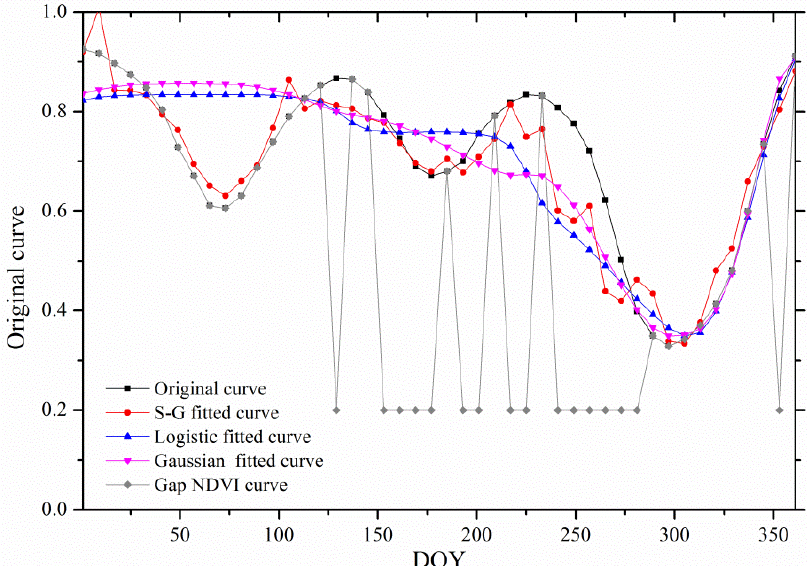
Figure 3. Comparison between S-G algorithm filtering, Logistic algorithm filtering, and Gaussian algorithm filtering, where the black line denotes the original NDVI curves, which are sampled from a clear sky rice growth point; the red line denotes the S-G-algorithm-fitted NDVI curve with our manually generated gap NDVI curve; the Logistic fitted curve is denoted by the blue line; and the Gaussian-algorithm-fitted simulated gap NDVI is denoted by the green line.